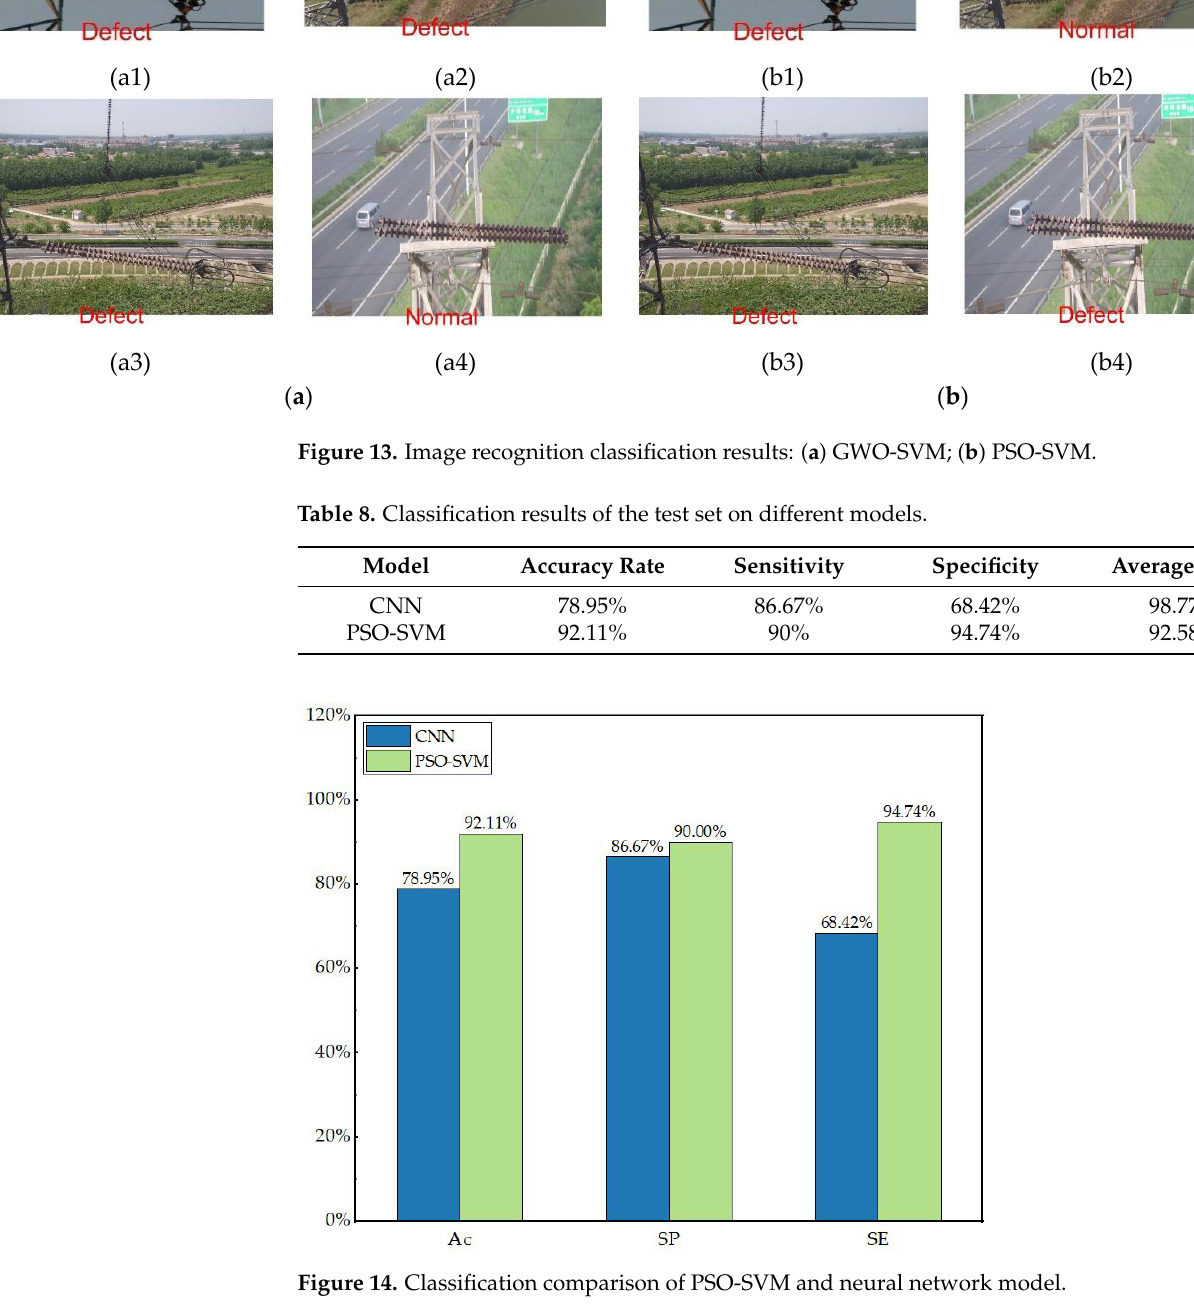
Figure 14. Classification comparison of PSO-SVM and neural network model.